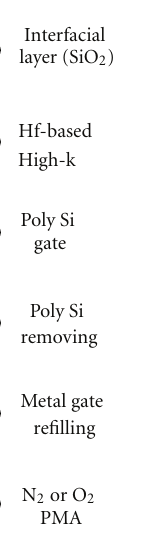
Figure 3: The I G - V G curves for samples with various PMA treatments.